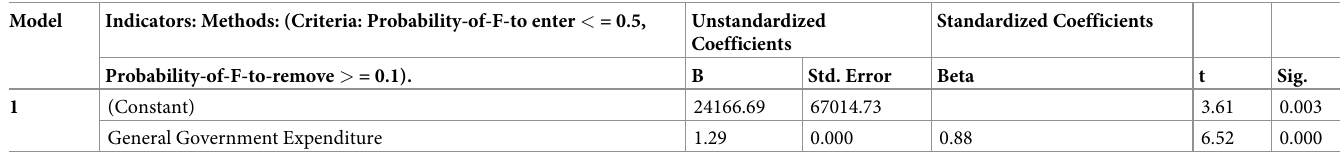
Table 6. Regression coefficients for the relationship between female enrollment, socio-economic factors (general government expenditure, unemployment rate, per capital income, GDP per capita (PPP constant 2011 international $), and GDP at market price) of Pakistan during 2001–02 to 2015–16.